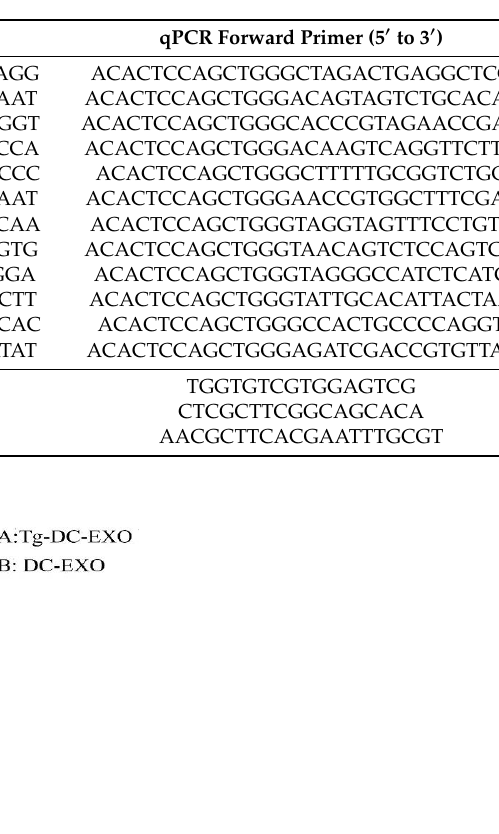
Table 2. Reverse transcription primers and qPCR primers for validation of the DEmiRs.